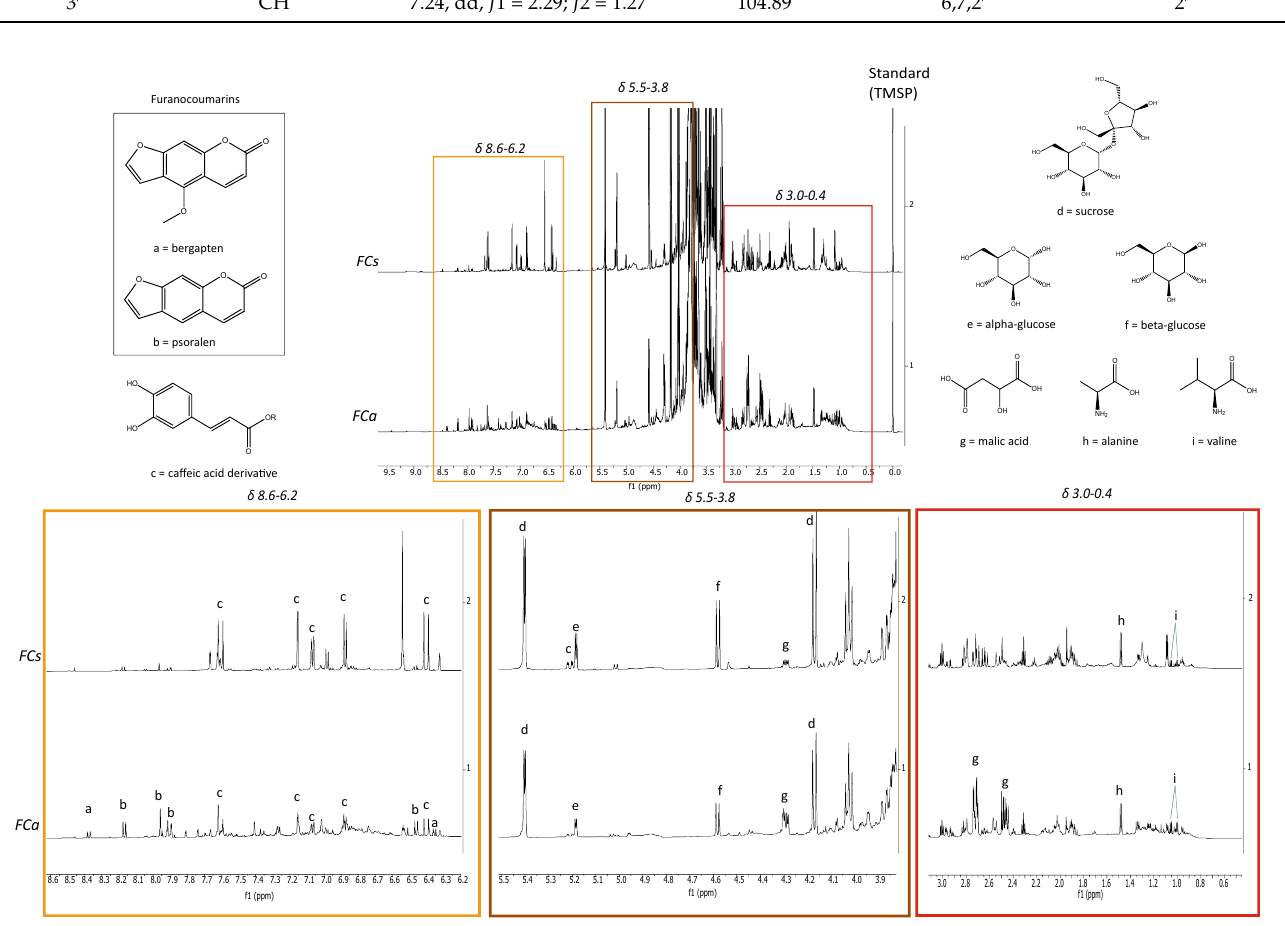
Figure 1. Comparison of 1 H-NMR profiling of FCs and FCa: on top, entire spectrum; at the bottom, region from δ 8.6 to 6.2 (orange), region from δ 5.5 to 3.8 (brown), region from δ 3.0 to 0.4 (red) where a = bergapten, b = psoralen, c = caffeic acid derivative, d = sucrose, e = α -glucose, f = β -glucose, g = malic acid, h = alanine, i =